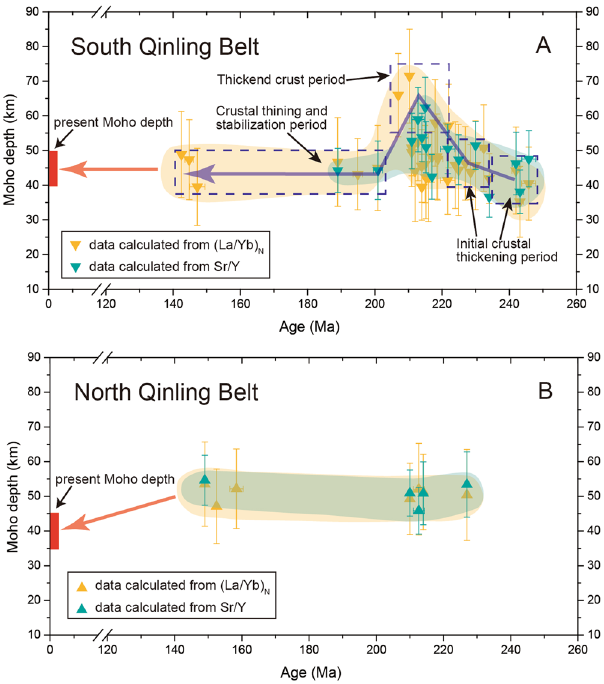
Figure 5. Changes of calculated crustal thickness from Sr/Y and (La/Yb) N over time for the South Qinling Belt ( A ) and North Qinling Belt ( B ). Crustal thickness with uncertainty is calculated by using the correlation equations in this study. Note that five subsets (Xiekeng, Maixiu, Xinyuan, Longcaoping, and Liuba) are used fits from Profeta et al . (2015) 7 to calculate (La/Yb) N -based Moho depth. The plotted data are listed in Supplementary Information. See text for